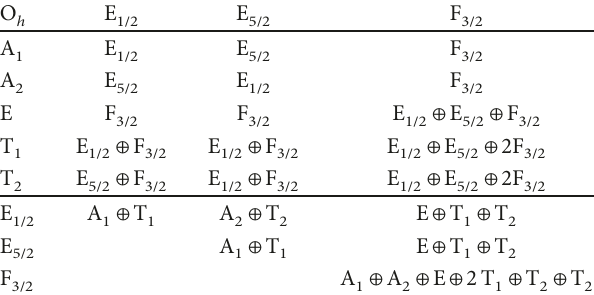
Table 5: Direct products of representations (cont.) in O (SOC). Note that in this table, the parity ( g : gerade ; u : ungerade ) was omitted here as the table can be used for either case. For accurate labelling, the parity has to be added to the term symbol, where gerade times gerade equals gerade and gerade times ungerade equals an ungerade term